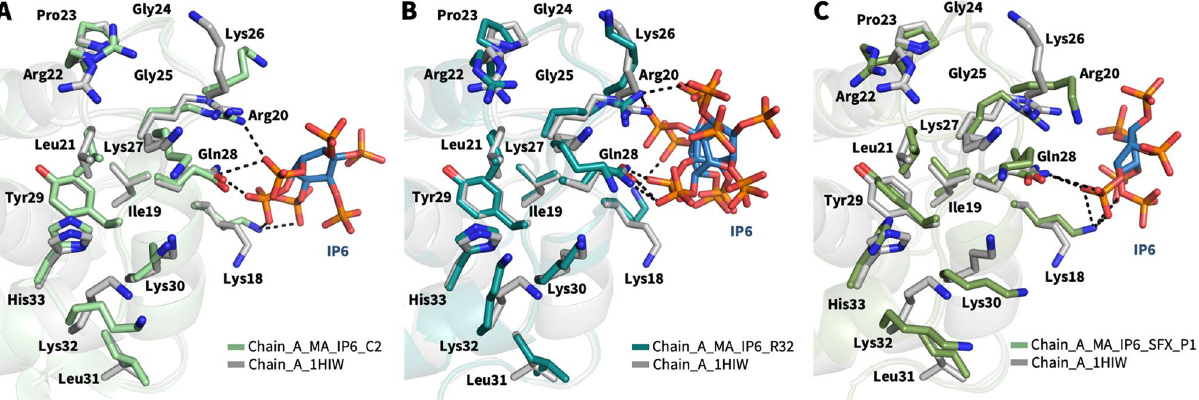
Figure 3. Superposition of MA domain structure (PDB ID: 1HIW) and our structures. ( a ) The chain A of our structure in green is superposed with chain A of MA domain (PDB ID: 1HIW) in gray, RMSD 0.279 Å. ( b ) The chain A of our MA_IP6_R32 structure in deep teal is superposed with chain A of MA domain (PDB ID: 1HIW) in gray, RMSD 0.273 Å. ( c ) The chain A of our MA_IP6_SFX_P1 structure in smudge is superposed with chain A of MA domain (PDB ID: 1HIW) in gray, RMSD 0.553 Å. The conformational changes on the residues in the HBR (18–33) are indicated and hydrogen bonds within the MA structures complex with IP6 are shown with dashed